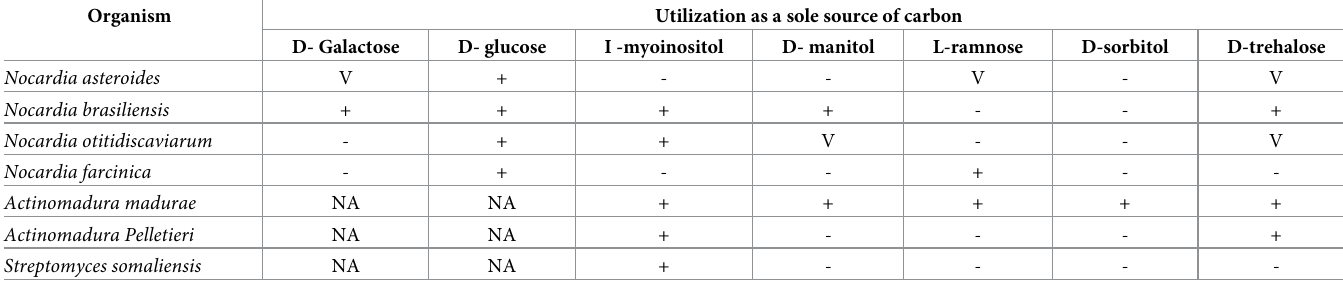
Table 4. Carbohydrates fermentation test for actinomycetoma